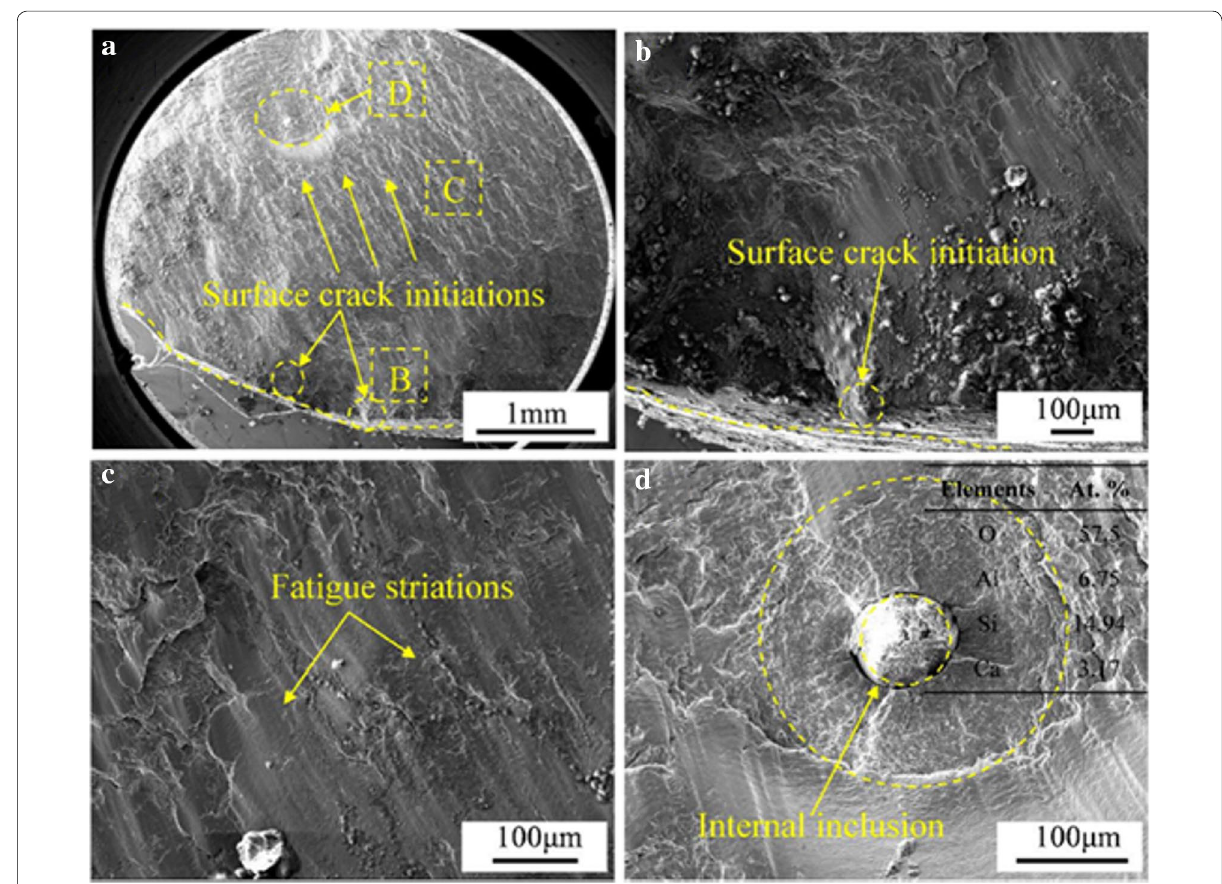
Figure 7 Fracture morphology of the specimen failed at WM at room temperature: a the overall morphology of fracture surface, b magnified micrograph of one surface crack initiation, c fatigue striations near the surface crack initiation, d internal inclusion in the final fracture